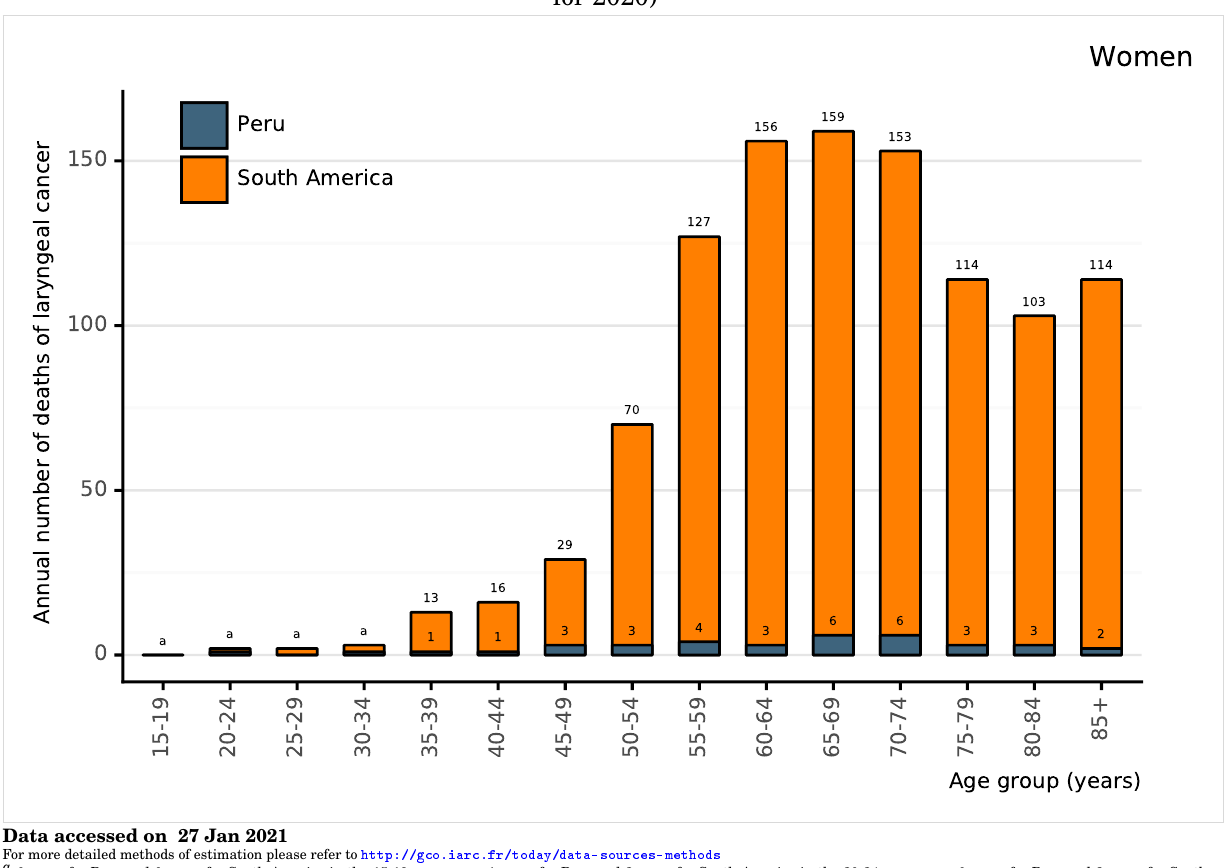
Figure 134: Annual number of deaths of laryngeal cancer among women by age group in Peru